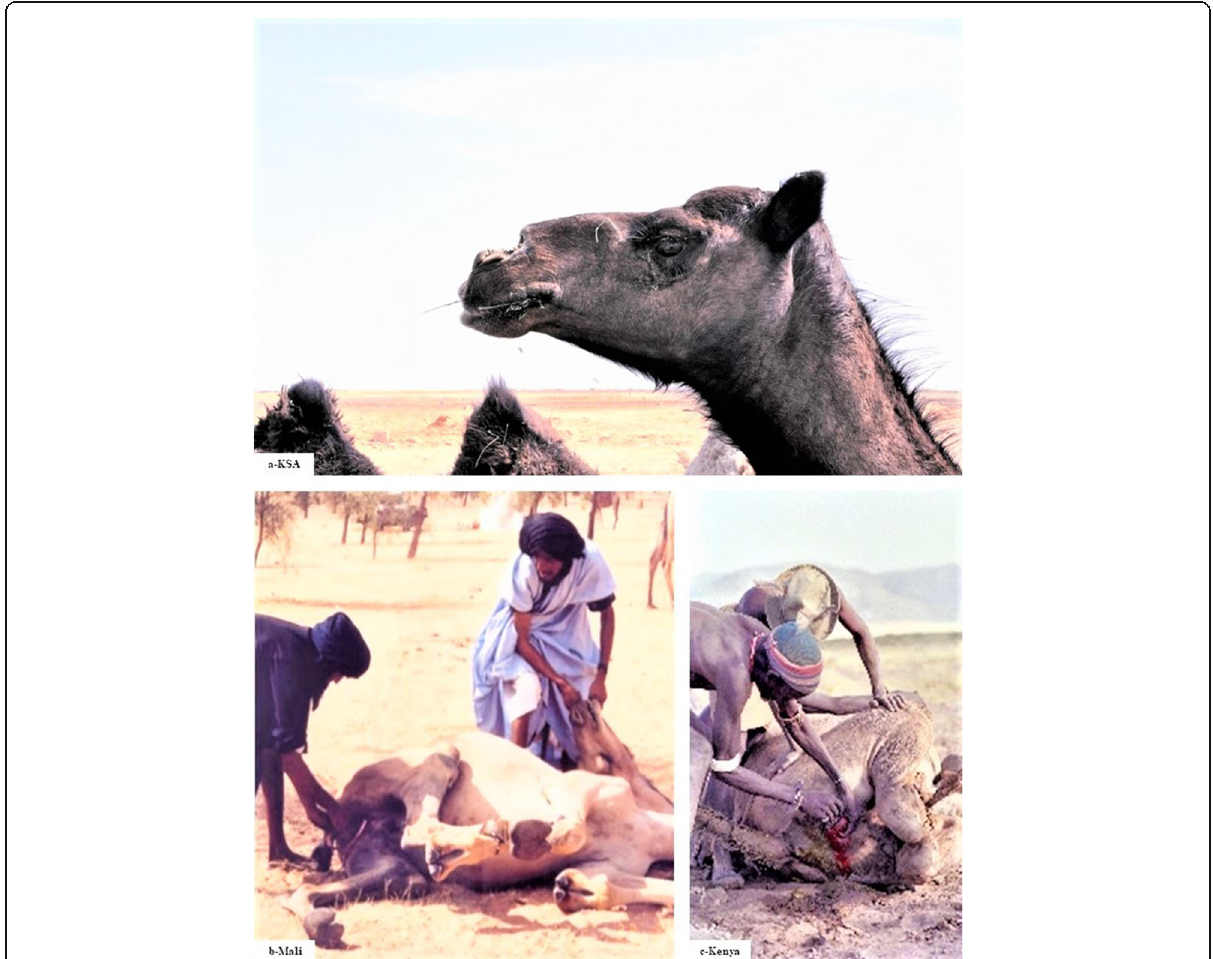
Fig. 14 Images of various ethnoveterinary treatments used by nomadic camel pastoralists in a variety of countries (Dioli 2012,2013, Schwartz and Dioli 1992). a KSA. b Mali. c